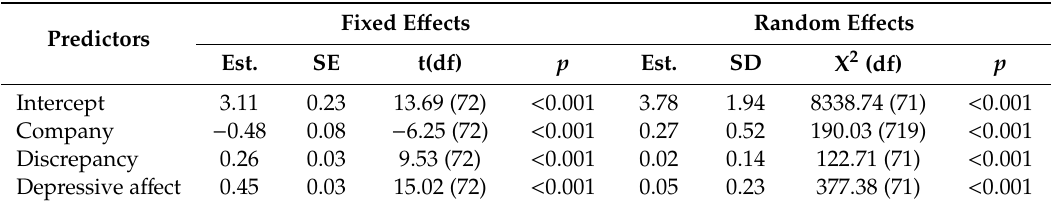
Table 1. Parameter estimates for multilevel model 1.